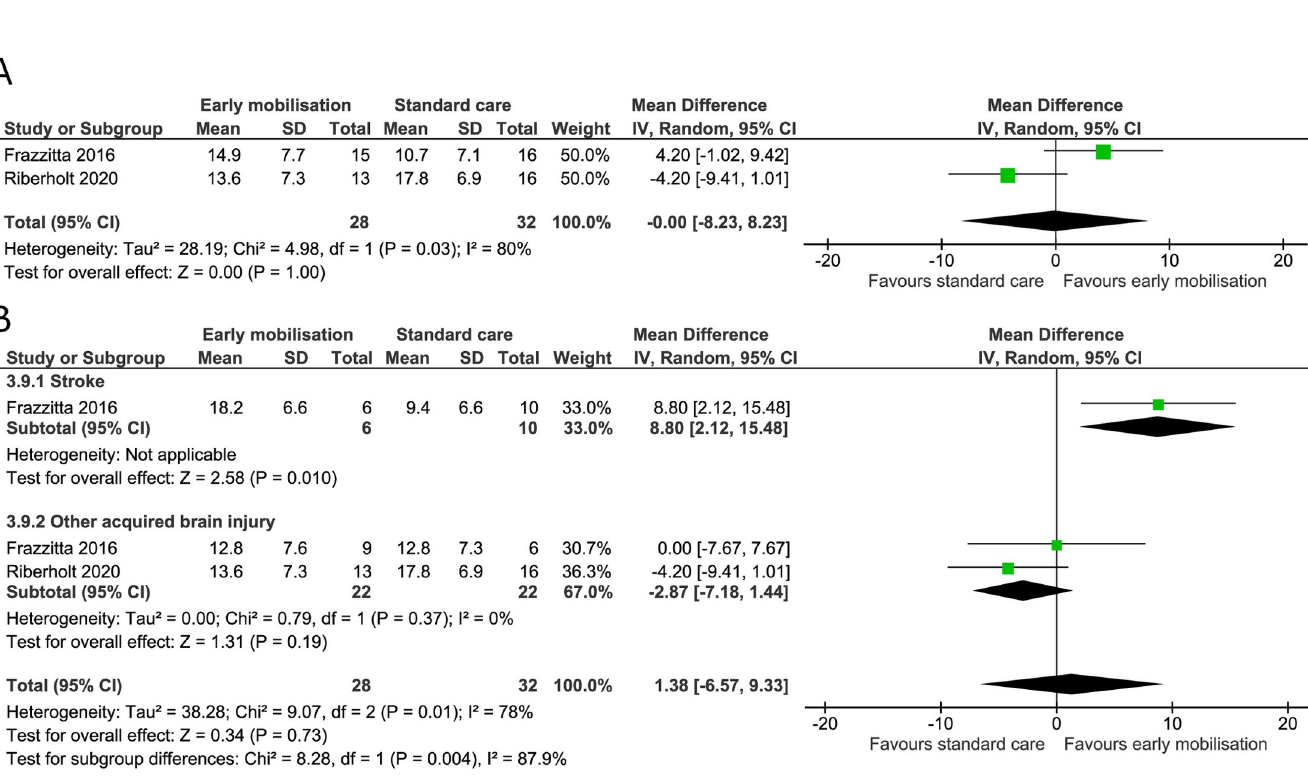
Fig 15. Comparison of early mobilisation versus standard care–Adverse events not considered serious at the end of the intervention. Fig 15A and 15B. Forest-plot showing the results from the fixed-effect meta-analysis of the outcome adverse events not considered serious at the end of intervention with subgroup divided according to risk of bias (A) or diagnosis